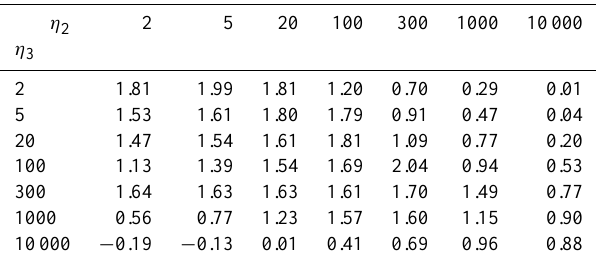
Table A2. Tangent of the slope of the curve showing the depen- dence of the logarithm of L 2 -error for velocity component v x on the logarithm of the grid step for different viscosity contrasts. Lin- early varying viscosity.